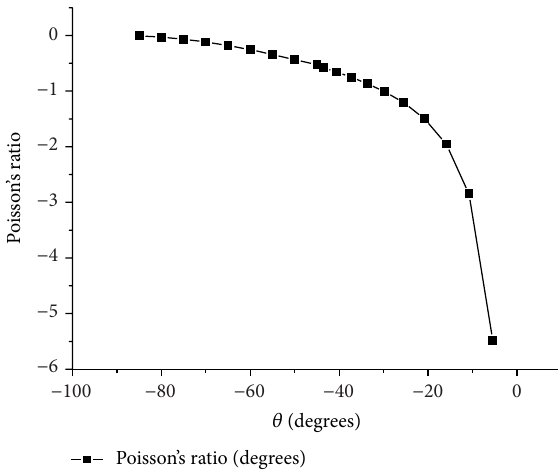
Figure 5: ] 21 versus 𝜃 calculated from (2) for equal-height cells, where ℎ/𝑙 = 2 , 2𝑙 cos 𝜃 = 42.86 mm, and 𝑡 = 1 mm.